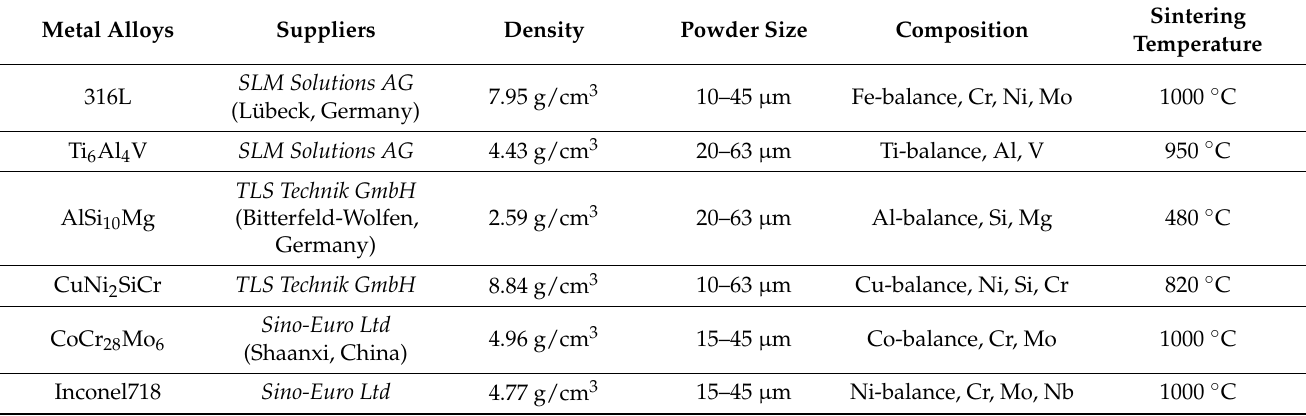
Table 1. Metallic alloys specification: Supplier companies, density, composition, and sintering temperature. All samples were made at 50 MPa pressure, 20 mm graphite mold, 100 ◦ C/min heating rate (ramp rate), and 5 min holding in sintering